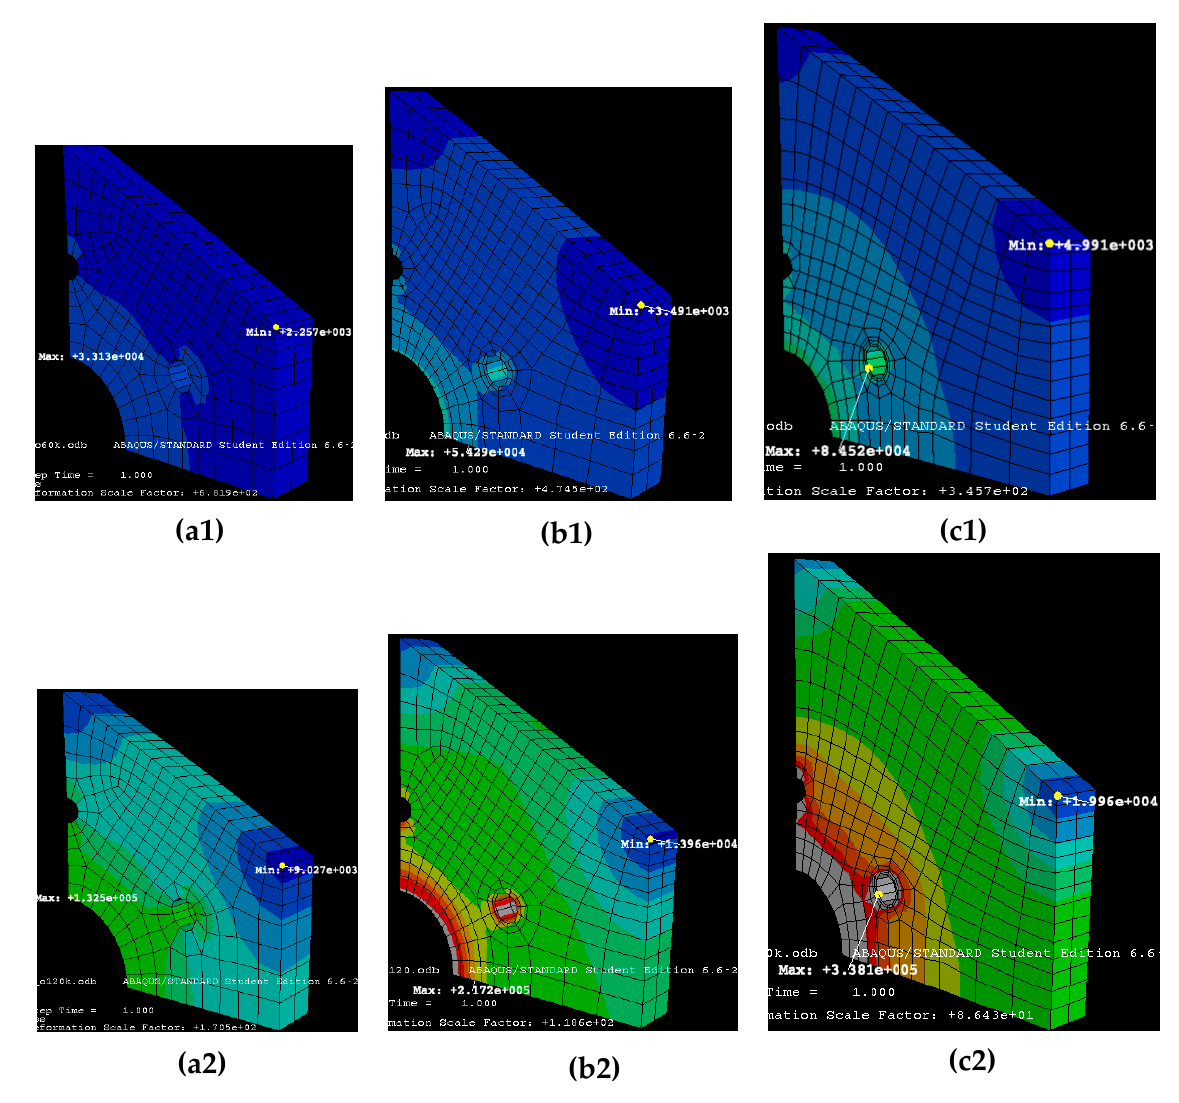
Figure 13. Variation of σ max and σ min of hexagonal rotational PMs (with b = 10 mm and r = 5 mm) for two levels of ω , ( 1 ) 60 krpm and ( 2 ) 120 krpm, for three values of R : ( a ) 20 mm, ( b ) 25 mm, and ( c ) 30 mm.